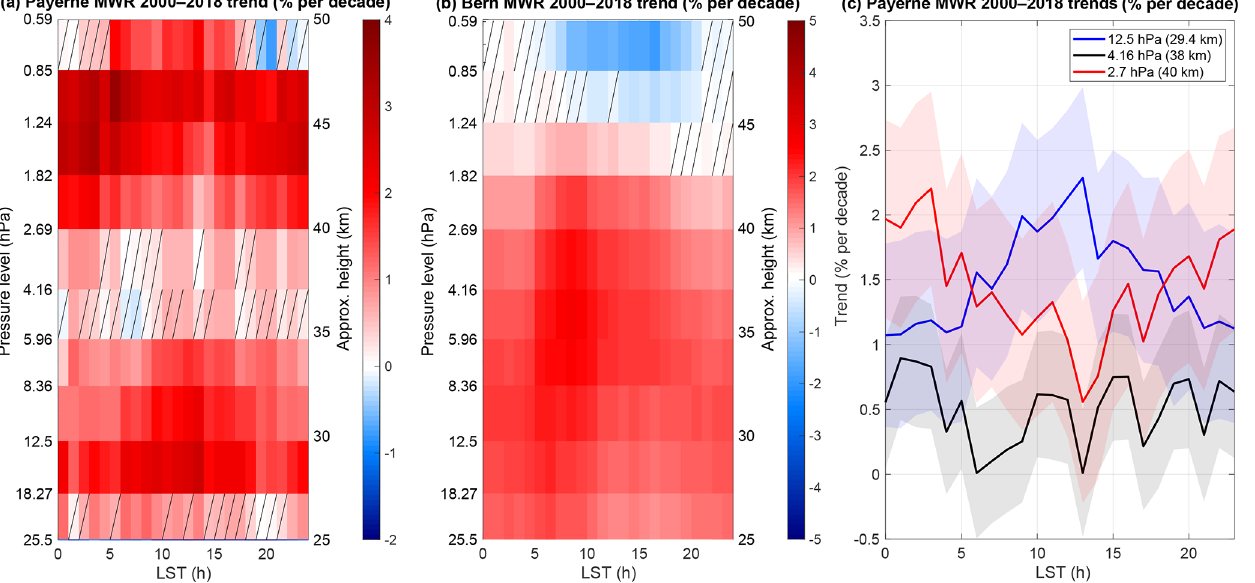
Figure 9. Long-term trends in percent per decade vs. LST for the 2000–2018 period. Trend estimates nonsignificantly different from zero at 95% are hatched. (a) Payerne MWR 1h time resolution dataset, (b) Bern MWR 1h time resolution dataset and (c) Payerne MWR O 3 trends in percent per decade at 2.7hPa (red), at morning minimum (12.5hPa, blue) and at afternoon maximum (4.16hPa, black) pressure levels vs.